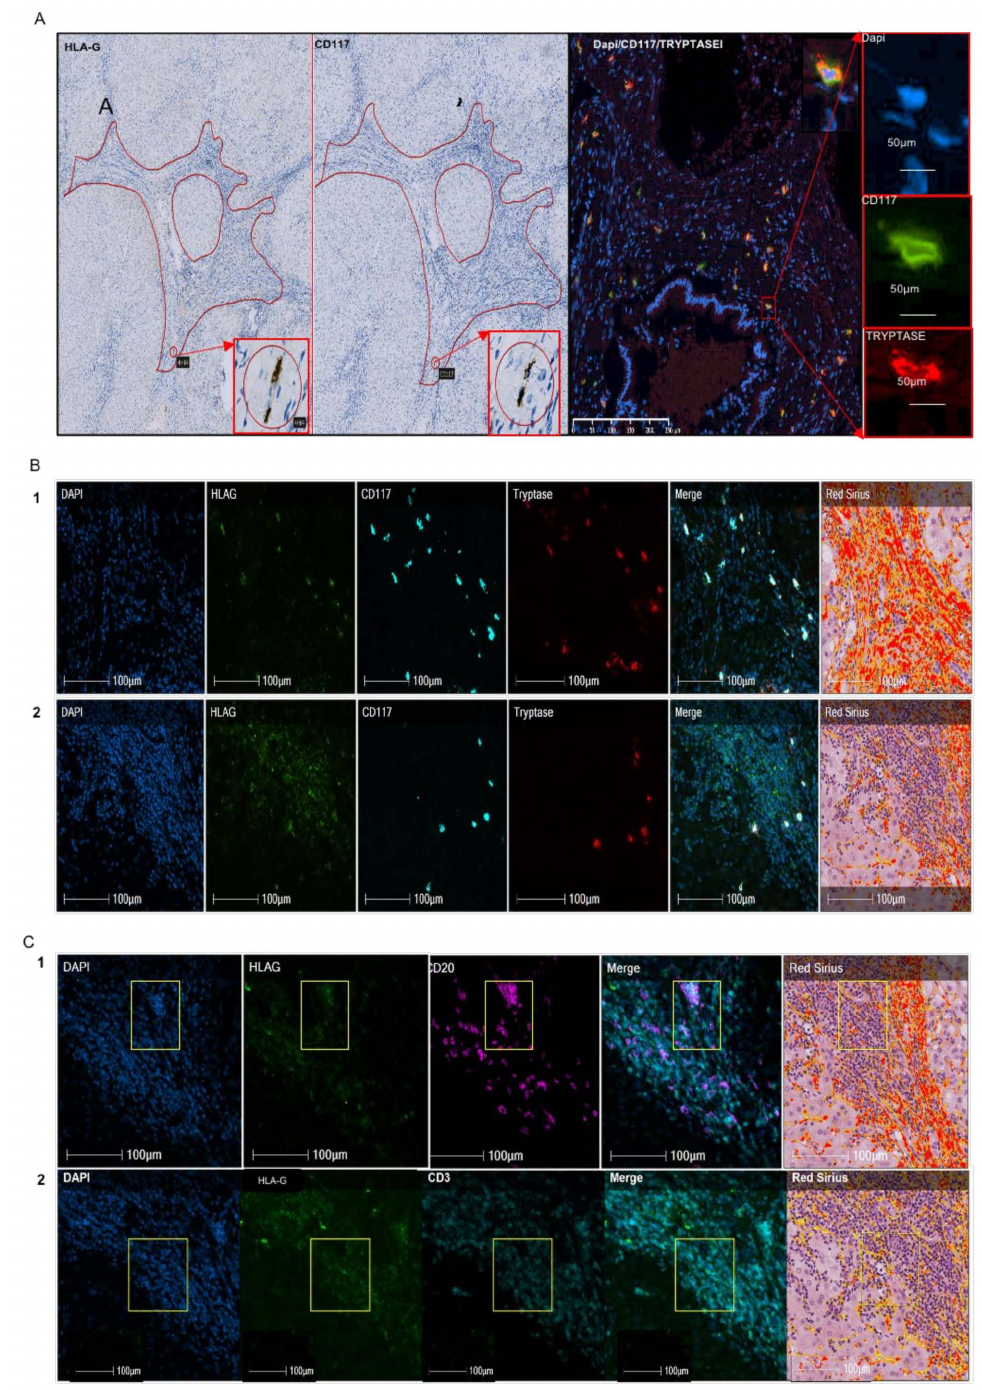
Figure 1. Nature of HLA-G cells on a representative case of liver fibrosis. ( A ) In the first paragraph, the two photos on the left show HLA-G and CD117 expression on a representative case of liver fibrosis out of 41 cases using immunohistochemistry, with 4H84 recognizing HLA-G and CD117 antibody recognizing c-kit cells. The slides were counterstained by Mayer hematoxylin. Fibrosis spans are surrounded by a red line. The areas in circles are topographically corresponding to HLA-G and CD117 stained slides. The rectangle shows a strong magnification of this areas indicating that the two HLA-G cells match the two CD117 cells. Moreover, they have a morphology compatible with a mast cell. The photo in double fluorescence (CD117/Mast cell tryptase) with the three photos on the right corresponding to the simple fluorescence (DAPI coloring the nuclei in blue, CD117 in green, mast cell tryptase in red) show a majority of cells co-labeled in yellow. The CD117 cells are largely mast cells. ( B ) Quadruple immunofluorescence on a representative case of liver fibrosis (out of